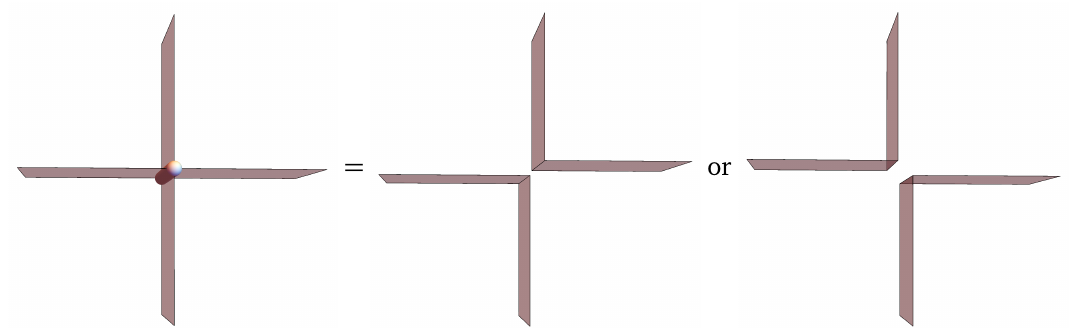
Figure 2: Two ways of resolving an edge with four incident walls. There is yet another choice (not shown) where it is resolved into two intersecting straight domain